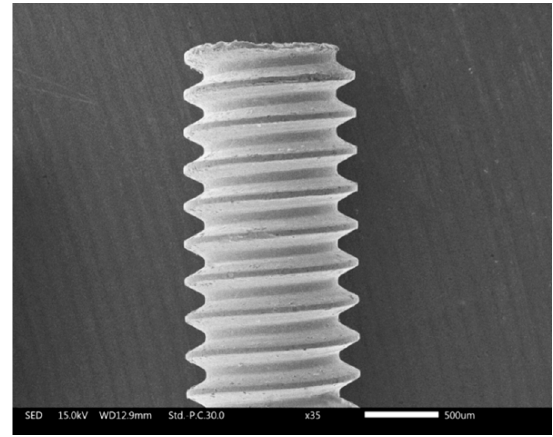
Figure 6. SEM (scanning electron microscope) image of the tube electrode with helical structure. Table 2. Experimental parameters of the electrical discharge machining (EDM) process.